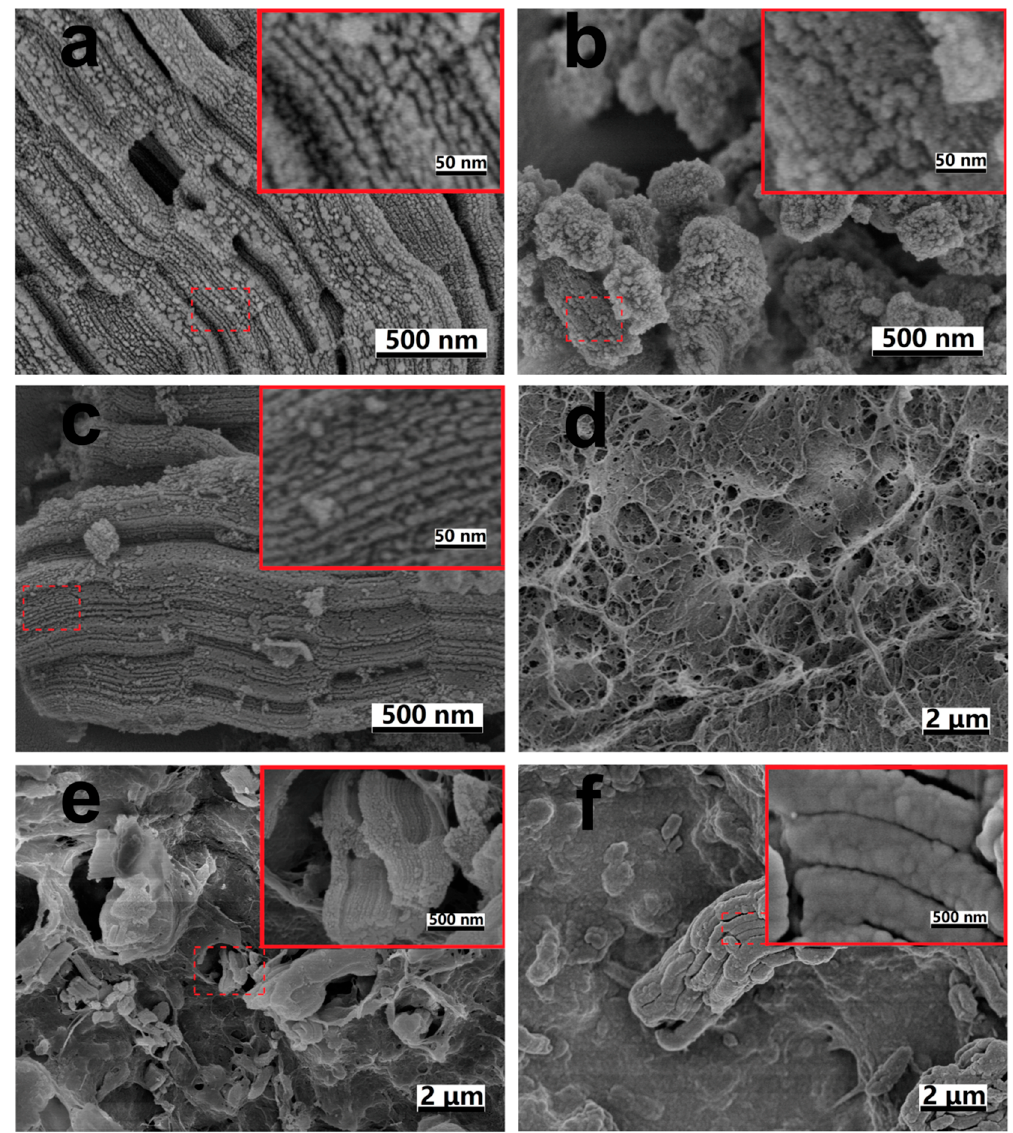
Figure 1. SEM images of ( a ) pristine SBA-15 particles; ( b ) CaCO 3 -coated SBA-15 particles, ( c ) remnant of calcined CM-Ca2-SBA(30%), ( d ) CM, ( e ) CM-Ca2-SBA(30%) and ( f ) CM-U-SBA(30%).